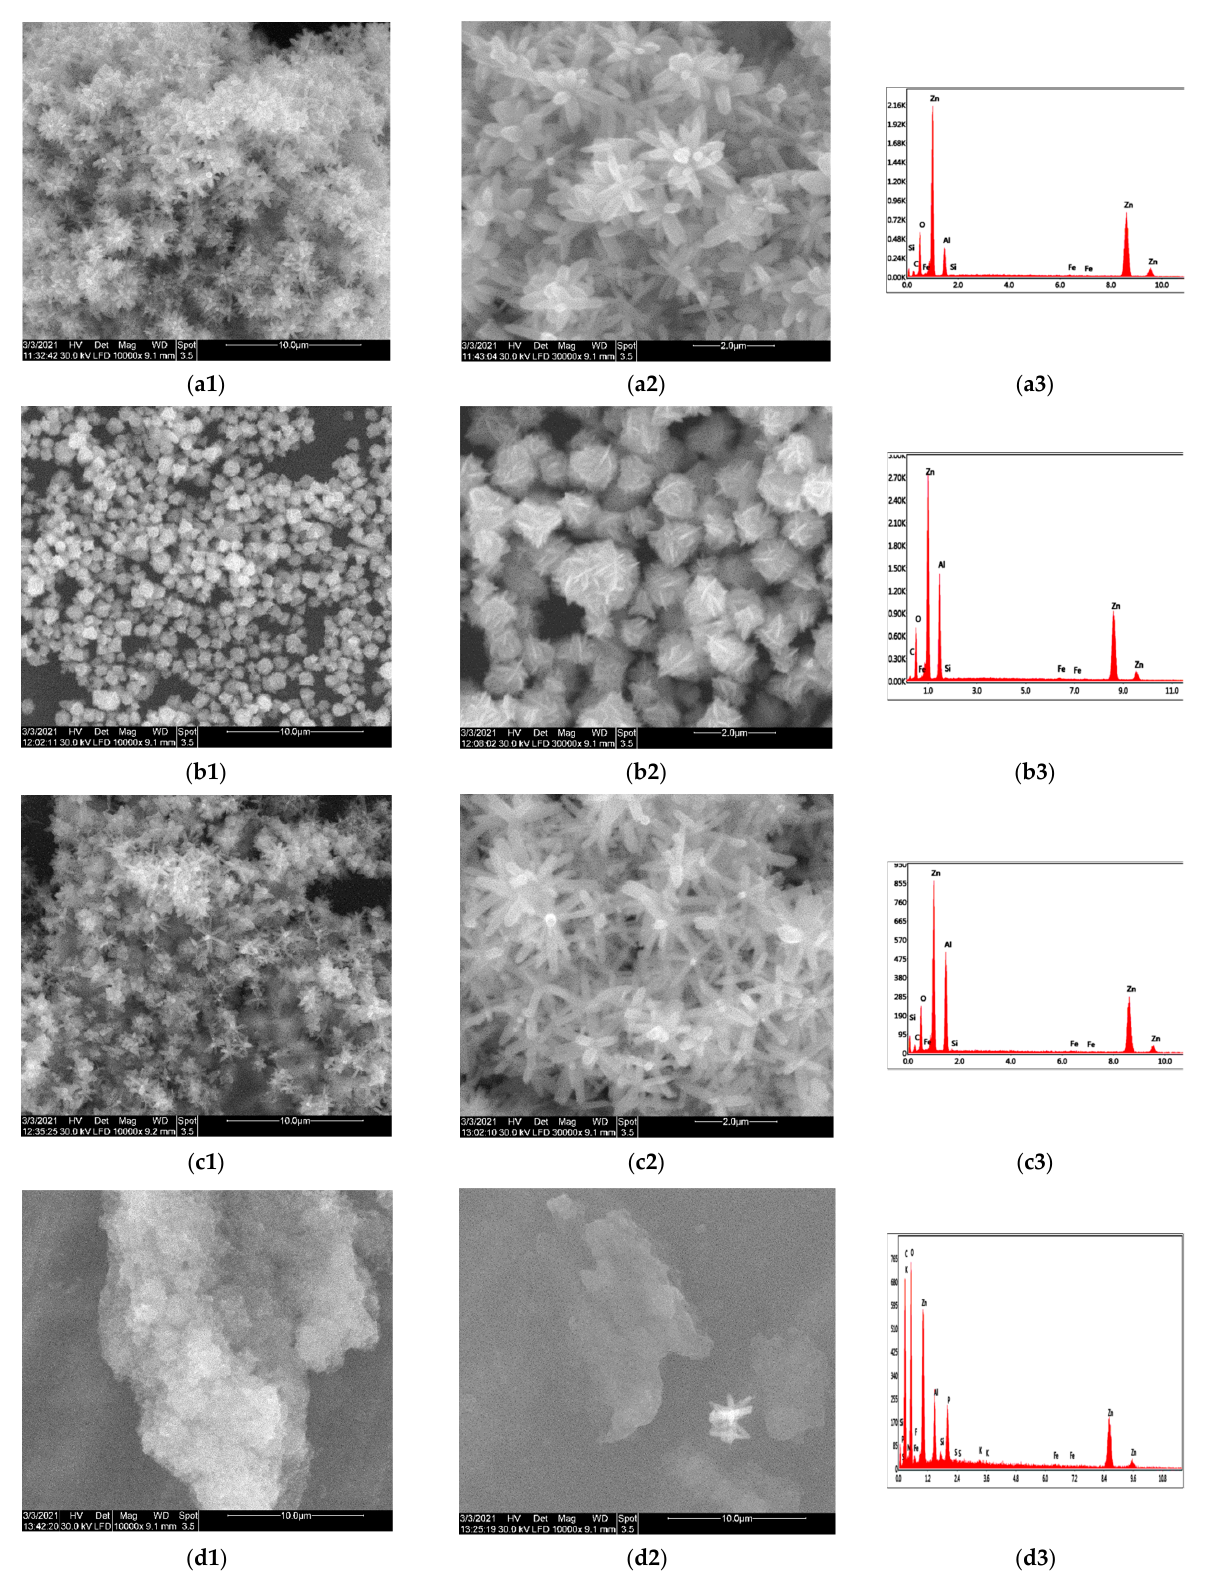
Figure 4. SEM micrographs, high-resolution images and EDX diagram of various flower-like 3D architectures of ZnO